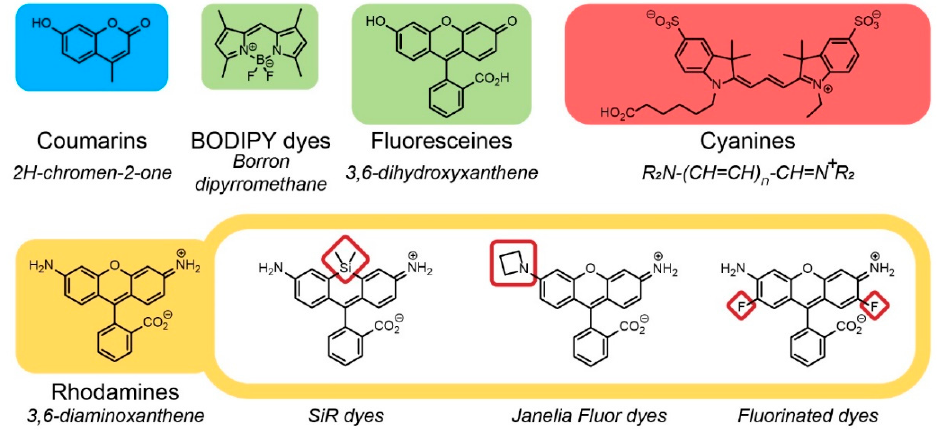
Figure 17. Examples of fluorescent dies with the background colored according to the wavelength maxima of fluorescence emission and examples of modifications of the rhodamines dye family (marked by the red square).